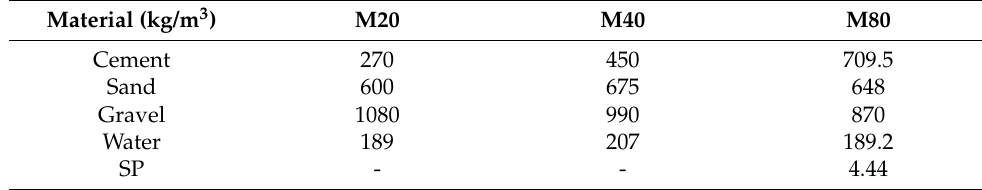
Table 1. Materials of the three mixtures (kg/m 3 ).